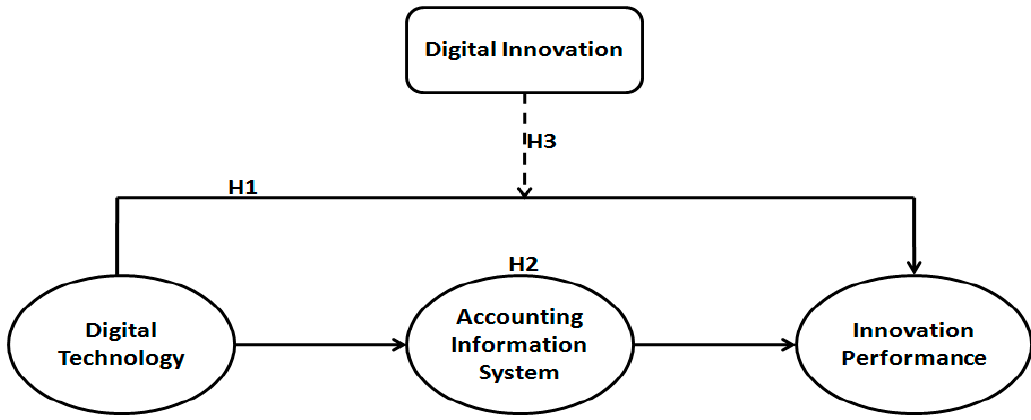
Figure 1. Theoretical Framework. Source: Authors’ concept.